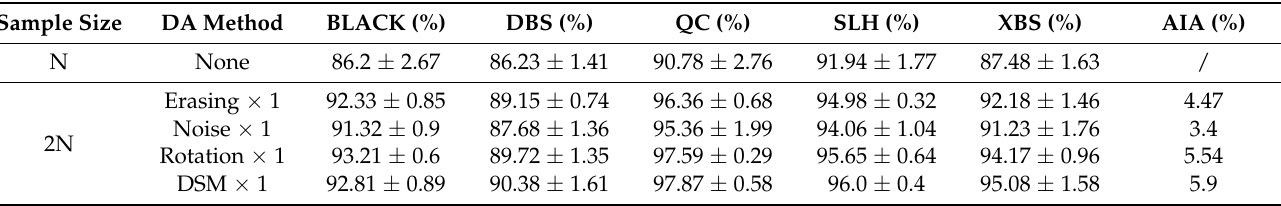
Table 4. Results of MobileViT-xs training using G1 and G2